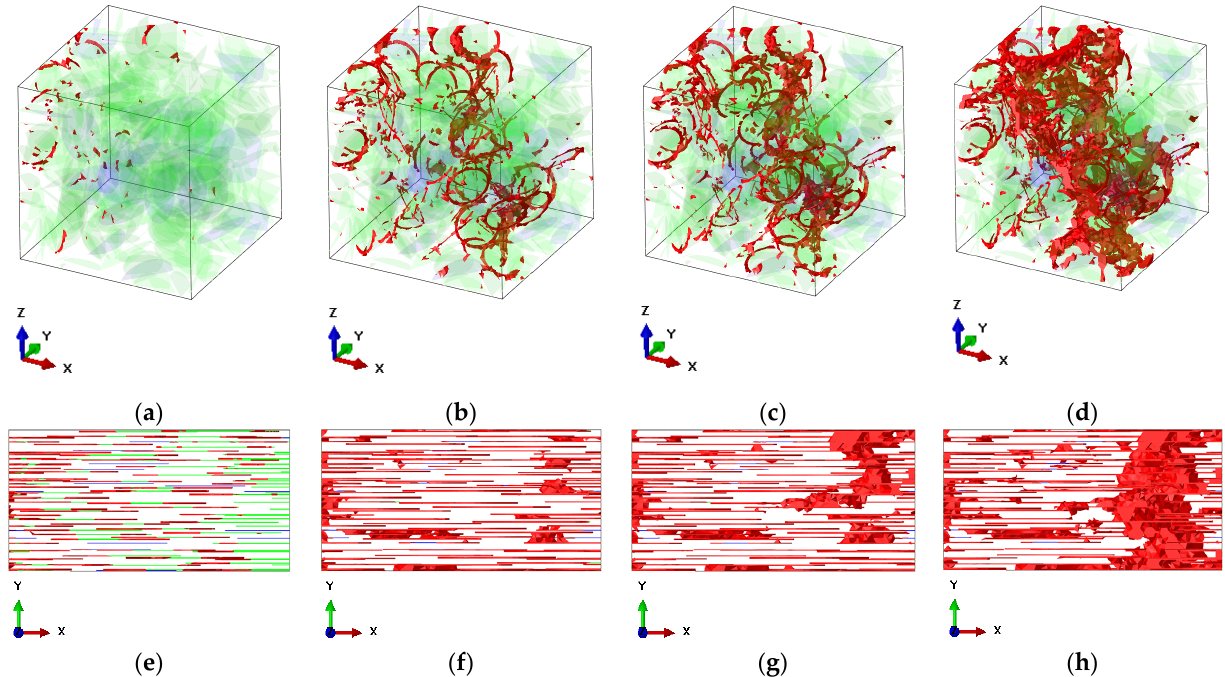
Figure 3. Damage evolution in the RVEs (damage is highlighted in red): ( a – d ) the RVE with randomly placed inclusions (the interface layers are hidden for better crack visualization, the MXenes are shown in transparent green, while the graphene inclusions are shown in transparent blue), ρ G = 500, ρ MX = 125, f G = 0.1%, f MX = 1.6%, and E MX = 0.5 E m : ( a ) at a strain of 0.016; ( b ) at a strain of 0.026; ( c ) at a strain of 0.029; ( d ) at a strain of 0.038; ( e – h ) the RVE with aligned inclusions (the MXenes are shown in green, while the graphene inclusions are shown in blue), ρ G = 500, ρ MX = 250, f G = 0.1% f MX = 3.2%, and E MX = 0.5 E m : ( a ) at a strain of 0.011; ( b ) at a strain of 0.036; ( a ) at a strain of 0.039; ( a ) at a strain of 0.045.